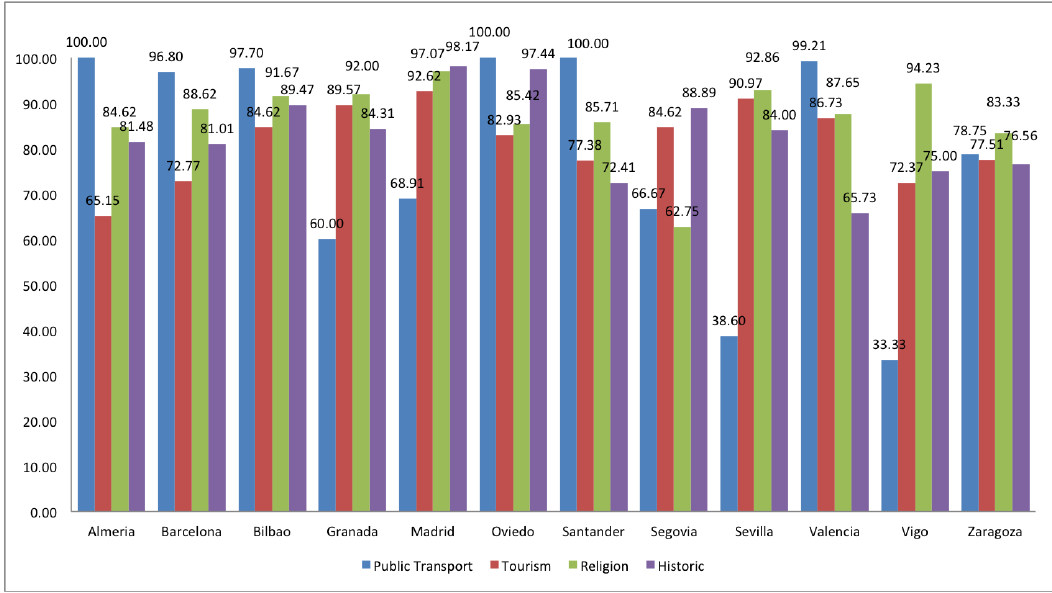
Figure 6. Completeness study in Spain. Percentage of name in public transport, tourism, religion and historic